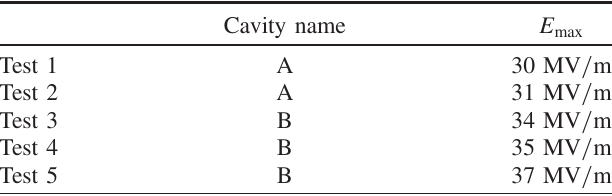
TABLE I. Cavity tests summary.